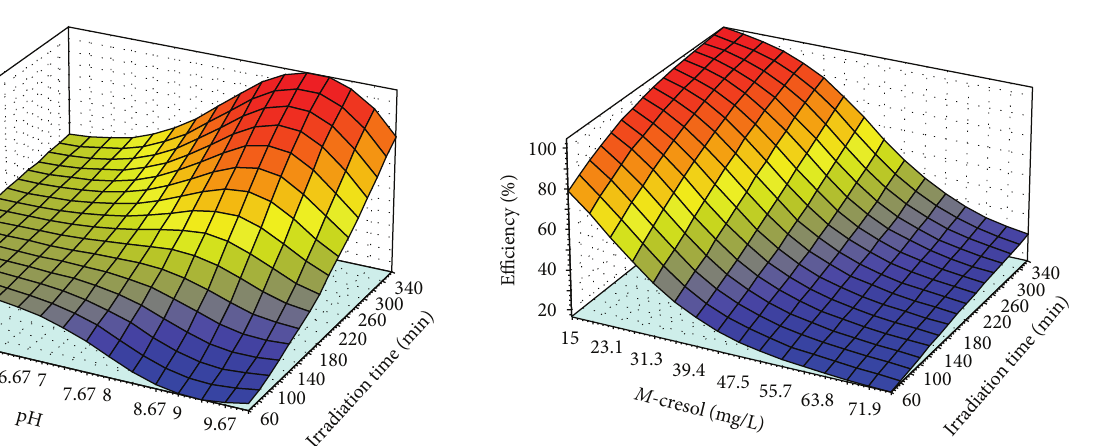
Figure 6: The variation of the photodegradation efficiency in pH 5 to pH 10 and irradiation time (60 to 360 min), the amount of photocatalyst (2g/L) and m -cresol (45.5 mg/L) were at middle of their levels.